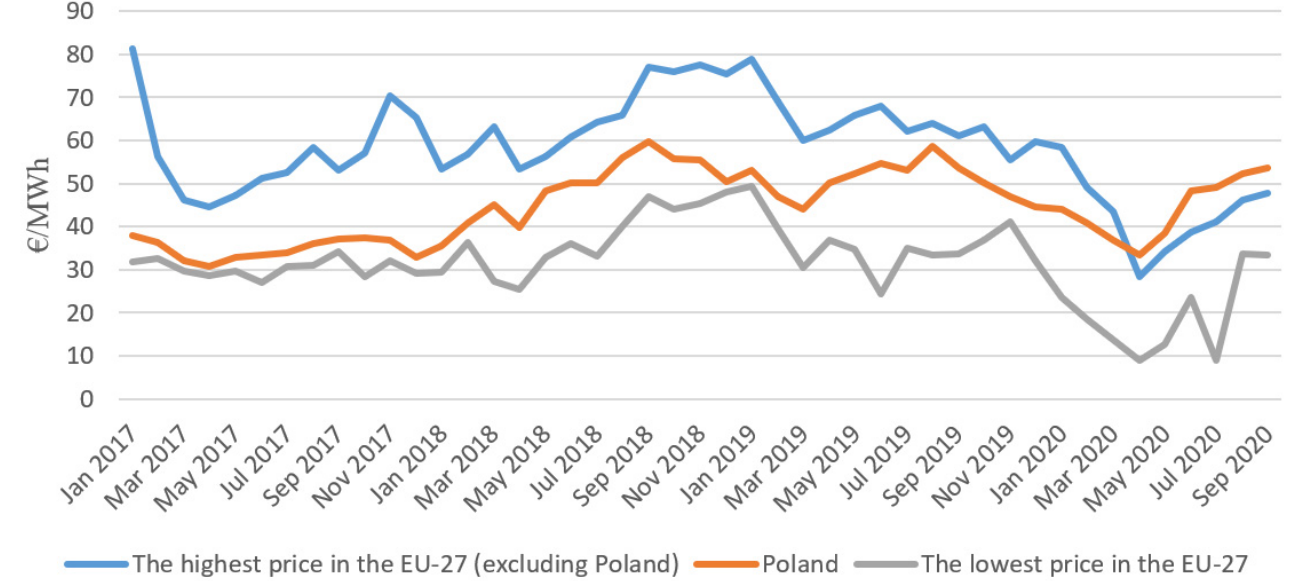
Figure 1. Wholesale electricity prices in the EU and Poland. Source: Ember’s own analysis of entso-e data (excluding Cyprus and Malta). Available online: https://ember-climate.org/commentary/2020/10/23/ceny-energii-elektrycznej-w-polsce-najwyzsze-w-europie/ (accessed on 10 June 2021).